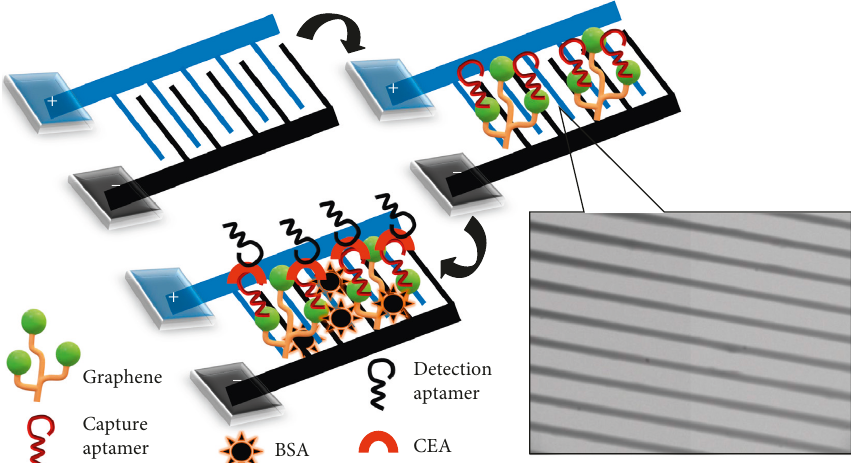
Figure 1: Graphical demonstration of the CEA aptasensor. A potassium hydroxide-treated electrode was constructed using COOH- activated graphene, and then, the anti-CEA aptamer was covalently immobilized onto the electrode surface through COOH with NH2. BSA was added to cover the excess activated surface, and then, the CEA was detected by the immobilized